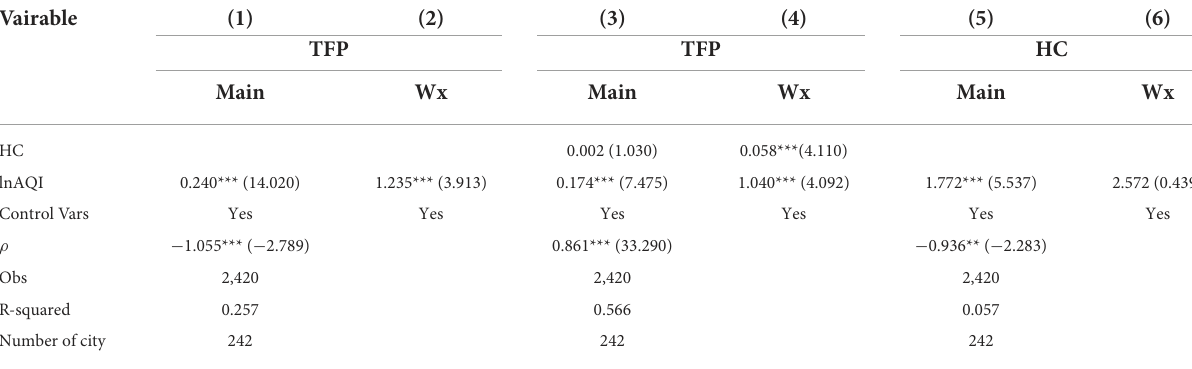
TABLE 15 The estimation results of mediating variable—human capital. Vairable